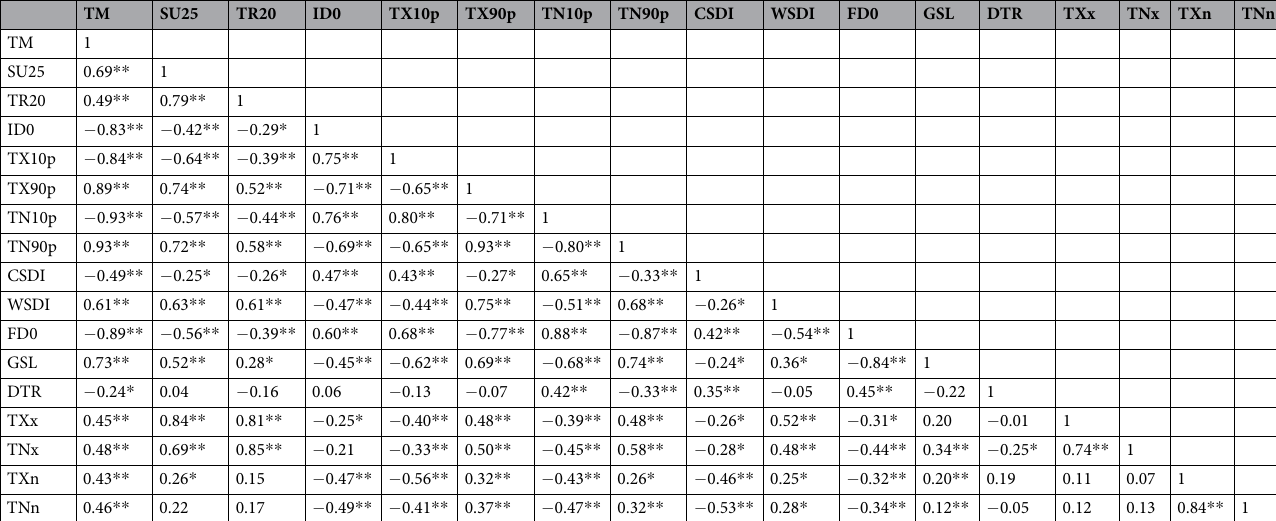
Table 2. Correlation coefficients for extreme temperature indices in the Qilian Mountains. For description of index names, see Supplementary Table S1. TM is daily mean temperature. * and ** represent significance at the 0.05 and 0.01 level,